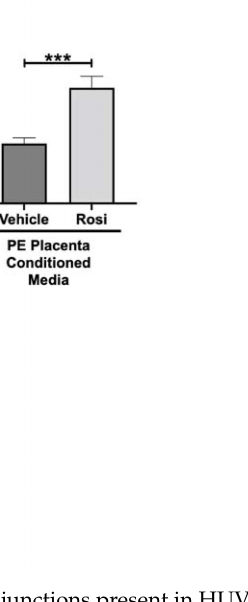
Figure 11. There is a reduction of junctions present in HUVECs cultured with preeclamptic